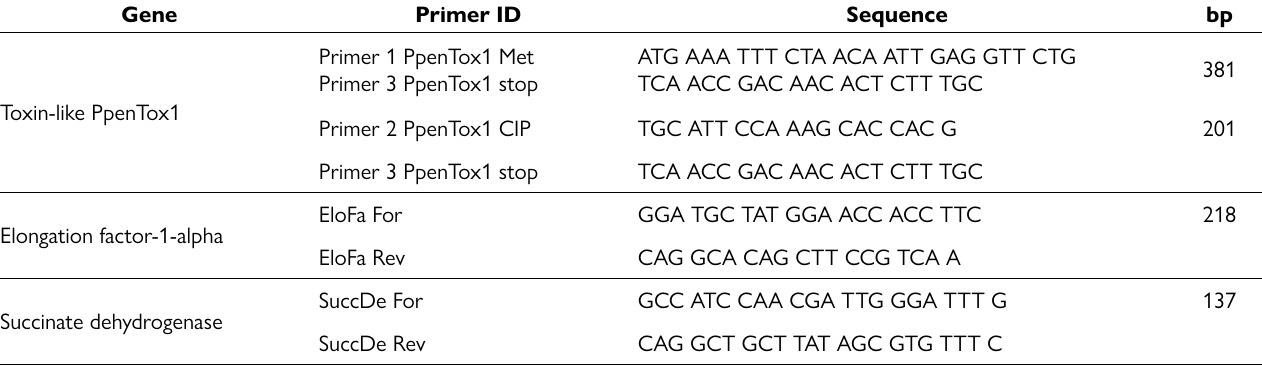
Table 1. Primers designed for the amplification of PpenTox1, elongation factor-1-alpha, and succinate dehydrogenase from Phonotimpus pennimani . Gene